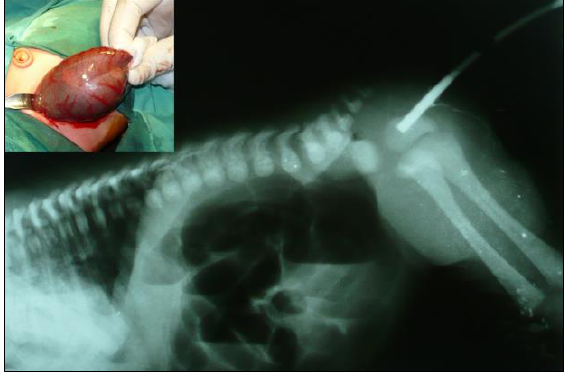
Figure 1: Invertogram showing a moderately dilated gas shadow in the pelvis at a distance of 2-3cm from contrast filled nelaton passed through the patent anus. Inset shows type 4 pouch